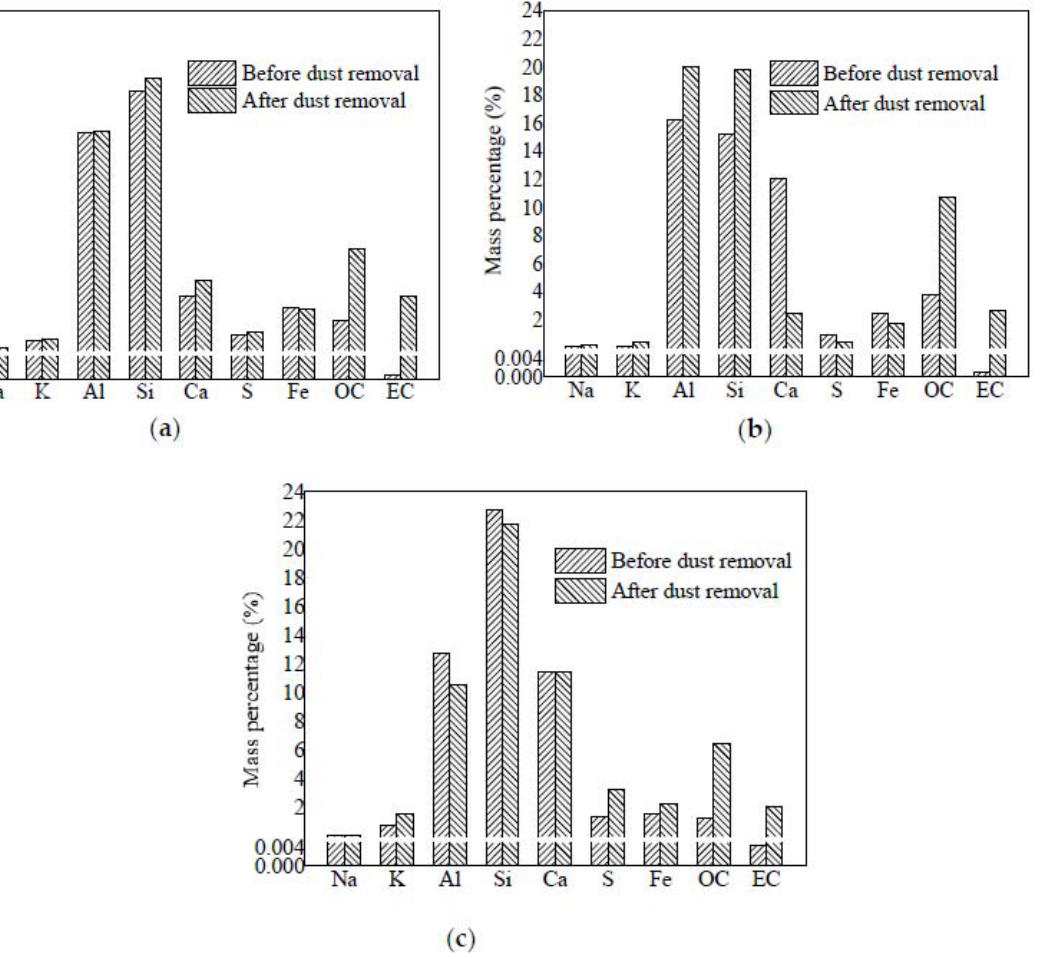
Figure 7. The contrast before and after dust removal of representative elements content of fine particle of CFB boiler. ( a ) Boiler 1; ( b ) Boiler 2; ( c ) Boiler